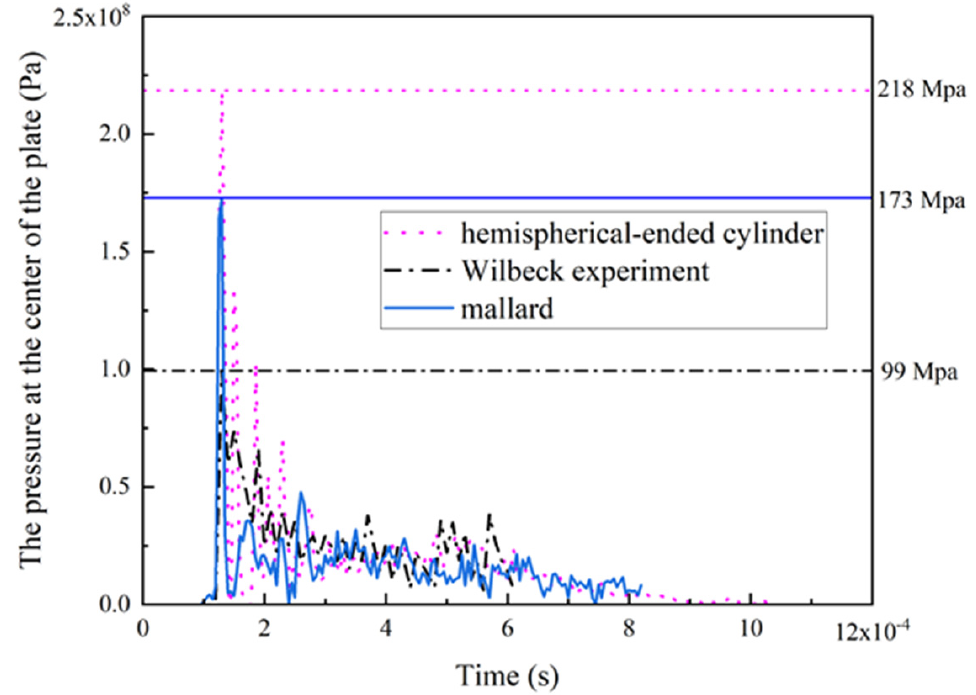
Figure 2. Comparison of the pressure at the center of the plate for the mallard and hemispherical- ended cylinder bird models and Wilbeck’s experiment.